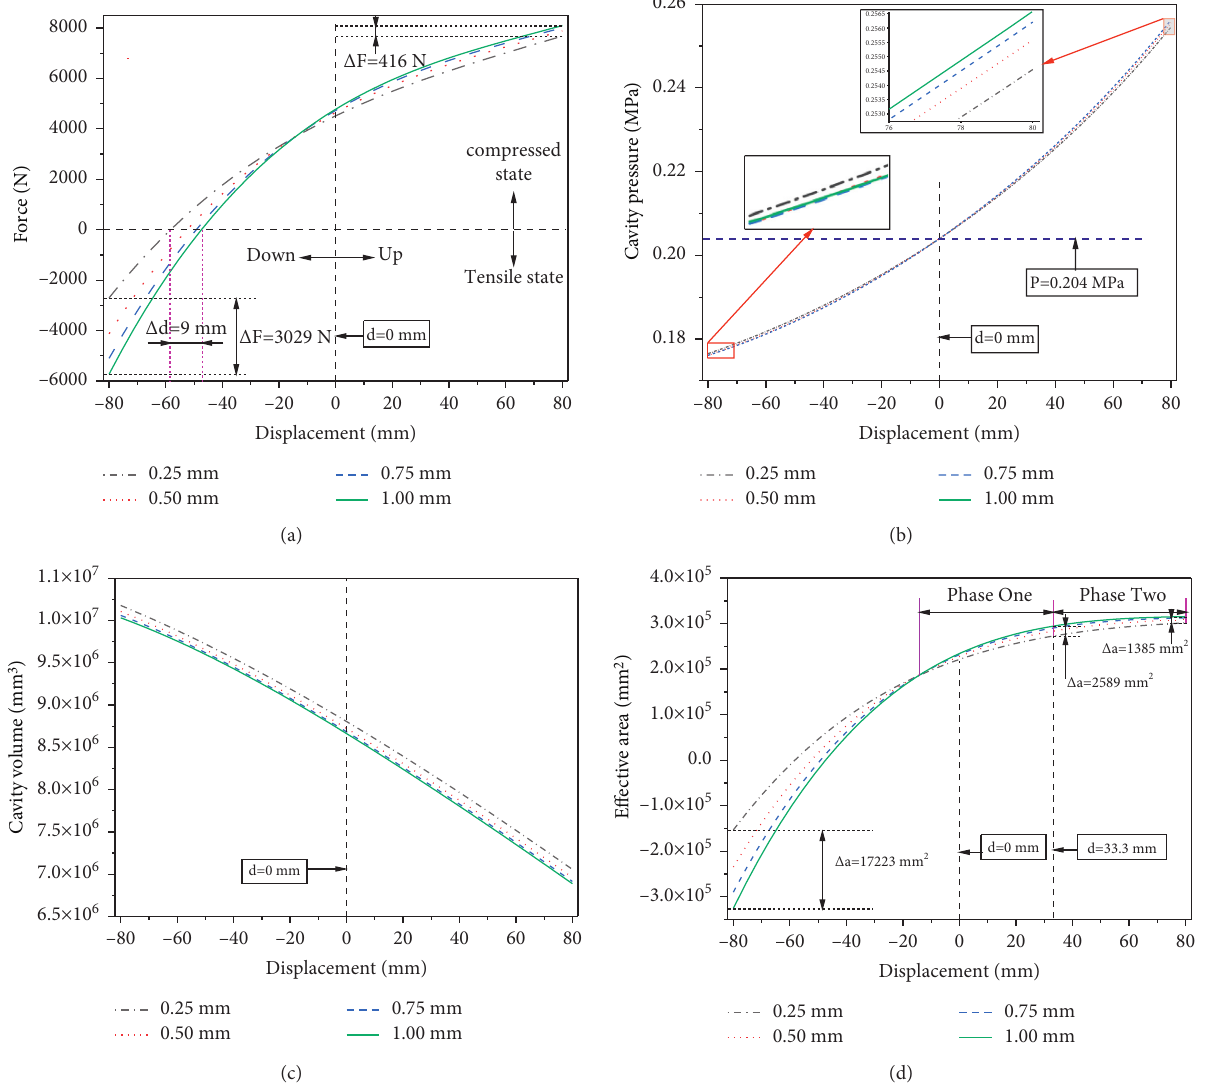
Figure 12: Effect of cord diameter on airbag: (a) for load, (b) for pressure, (c) for volume, and (d) for effective